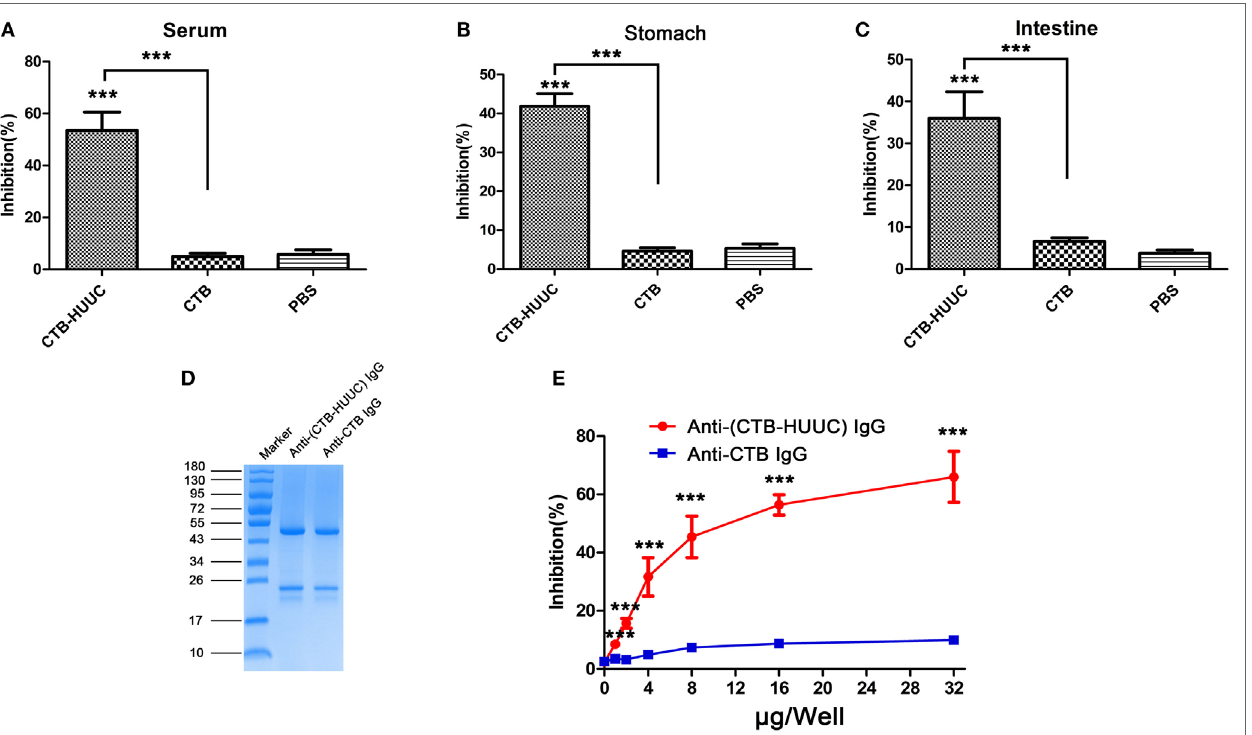
FigUre 3 | Inhibition of Helicobacter pylori urease activity by IgG or IgA from mice immunized with cholera toxin B subunit (CTB)-HUUC, CTB, or PBS. Serum (a) , stomach mucus (B) , and intestine mucus (c) from mice immunized with CTB-HUUC, CTB, or PBS were incubated with H. pylori urease. The H. pylori urease activity determined using neutralization assay. *** p < 0.001, compared with the PBS group or between the CTB-HUUC and the CTB groups. (D) Visualization of IgG purified from serum of mice immunized by CTB-HUUC or CTB. The purified IgG was resolved in 12% SDS-PAGE gel and stained with Coomassie Blue. (e) Neutralization of urease activity by IgG purified from serum of mice immunized by CTB-HUUC or CTB. H. pylori urease was pre-incubated with the purified serum IgG (0, 1, 2, 4, 8, 16, and 32 μ g/well). The optical density of the mixture was determined at 550 nm. The data are expressed as percentage inhibition. *** p < 0.001, compared with the PBS group or between the CTB-HUUC and the CTB groups.